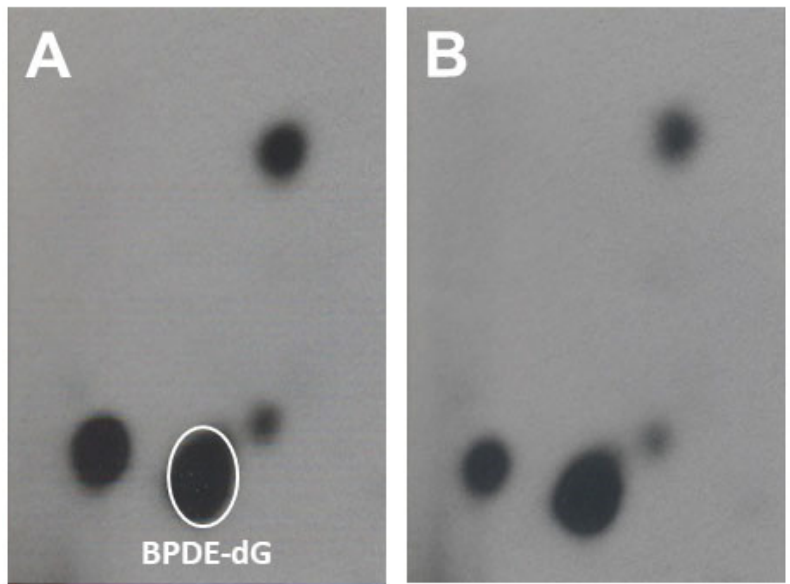
Figure 1. Representative DNA adduct profiles of lungs of B6FC3 mice fed with CO diet (Panel ( A )) and FO diet (Panel ( B )) treated Yeswith PAHs mixtures. After one month on a special diet, mice were treated with a high dose of PAHs by a single i.p. injection. BPDE-dG, BP trans-7,8-diol-9,10- epoxide-deoxy-guanosine. Mice were terminated at 7 d after PAHs treatment, and DNA adducts were analyzed by 32 P-postlabeling, as described under Materials and Methods.